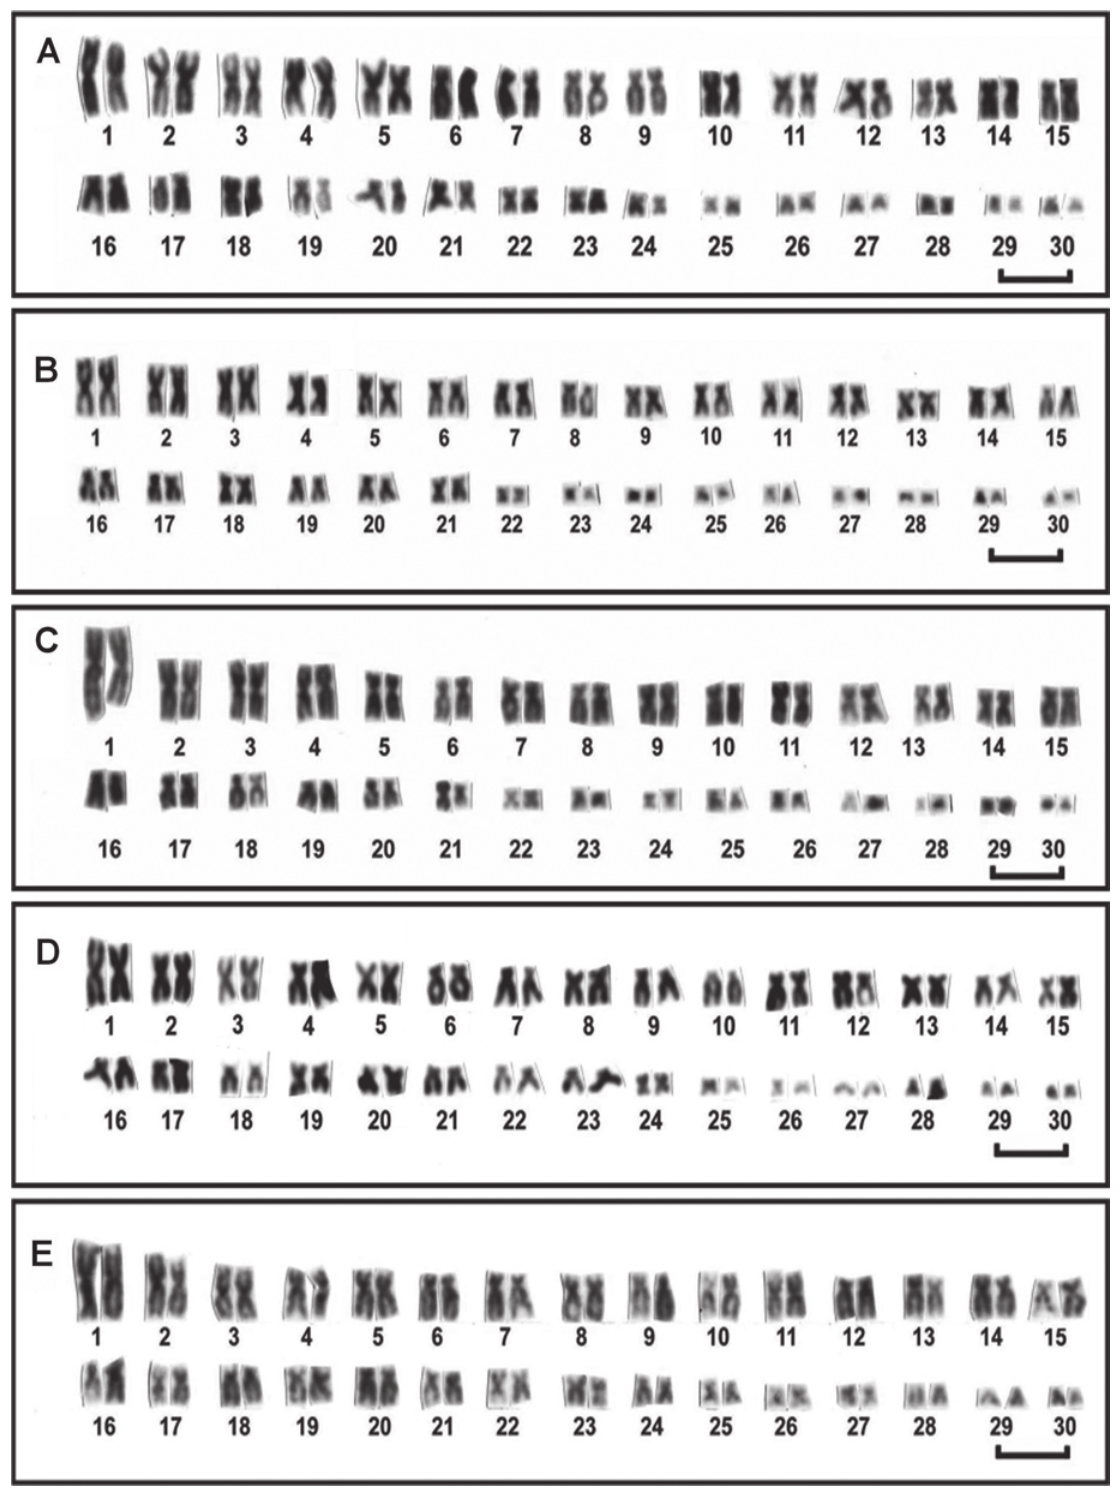
Fig. 2. Conventional Giemsa-stained karyotypes: (A) Symphysodon haraldi from Manacapuru, the pairs 26-27 are st-a and 29- 30 are microchromosomes; (B) S. aequifasciatus from Tefé (cytotype 1), the pairs 8, 15, 26 and 27 are st-a and 29-30 are microchromosomes; (C) S. aequifasciatus from Tefé (cytotype 2), the pairs 16, 26 and 27 are st-a and 29-30 are microchromosomes; (D) S. discus from Barcelos (cytotype 1), the pairs10, 27-30 are st-a; (E) S. discus from Barcelos (cytotype 2), the pairs 28-30 are st-a. Scale bar represents 5